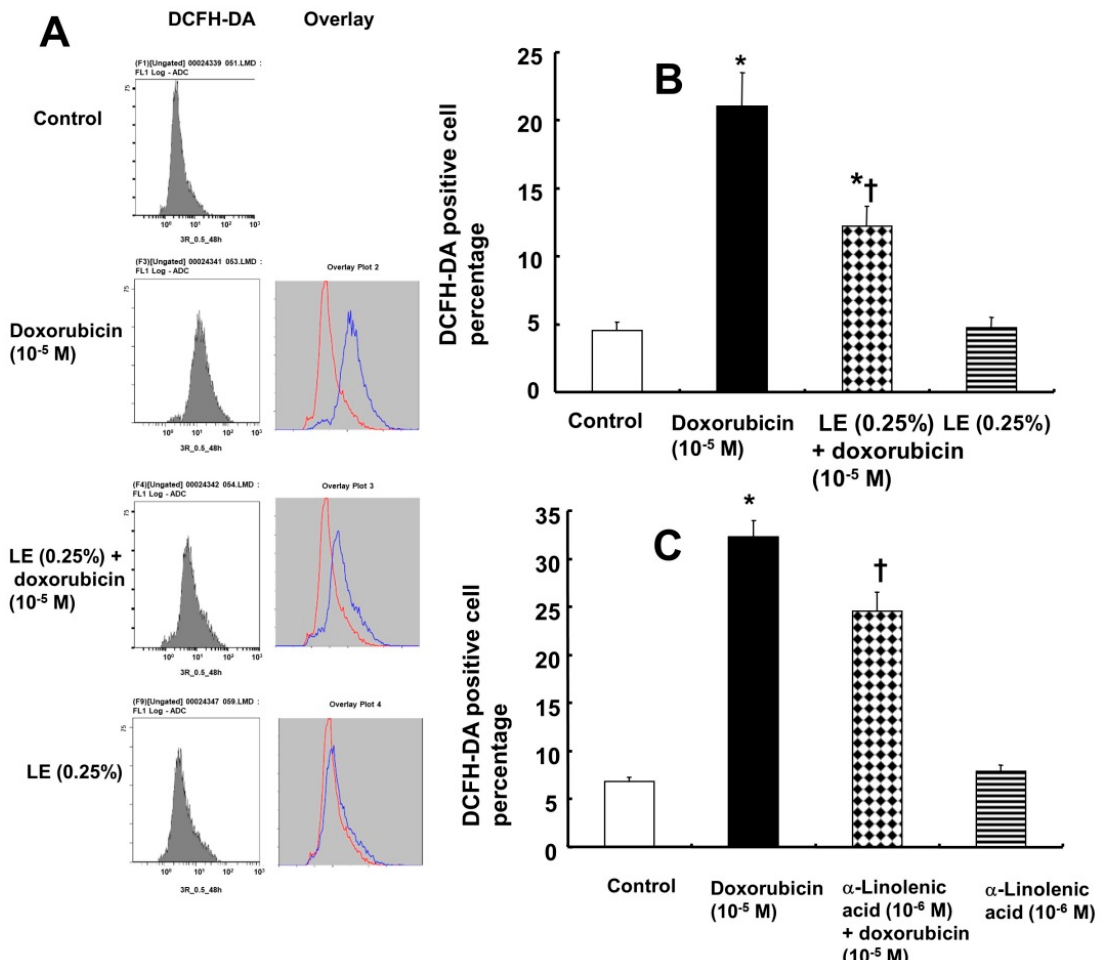
Figure 4. Effects of Intralipid ® (lipid emulsion, LE) on the doxorubicin-induced reactive oxygen species (ROS) levels in H9c2 rat cardiomyoblasts. Cellular ROS were measured by flow cytometry after staining with dichlorodihydrofluorescein diacetate (DCFH-DA) following treatment with doxorubicin (10 − 5 M) alone for 1 h, pretreatment with LE (0.25%) or α -linolenic acid (10 − 6 M) for 1 h followed by doxorubicin (10 − 5 M) for 1 h, or treatment with LE (0.25%) or α -linolenic acid (10 − 6 M) alone for 2 h. ( A , B ) Effect of LE on ROS levels compared with the control. ( C ) Effect of α -linolenic acid on ROS levels compared with the control. ( B , C ) Data are presented as the mean ± SD (N = 3). * p < 0.001 versus control. † p < 0.001 versus doxorubicin